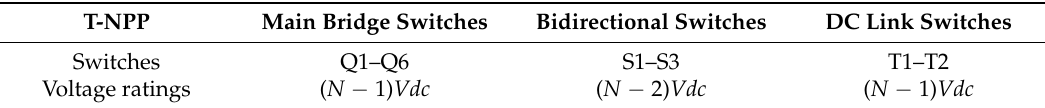
Table 7. T-NPP rating requirement per level N